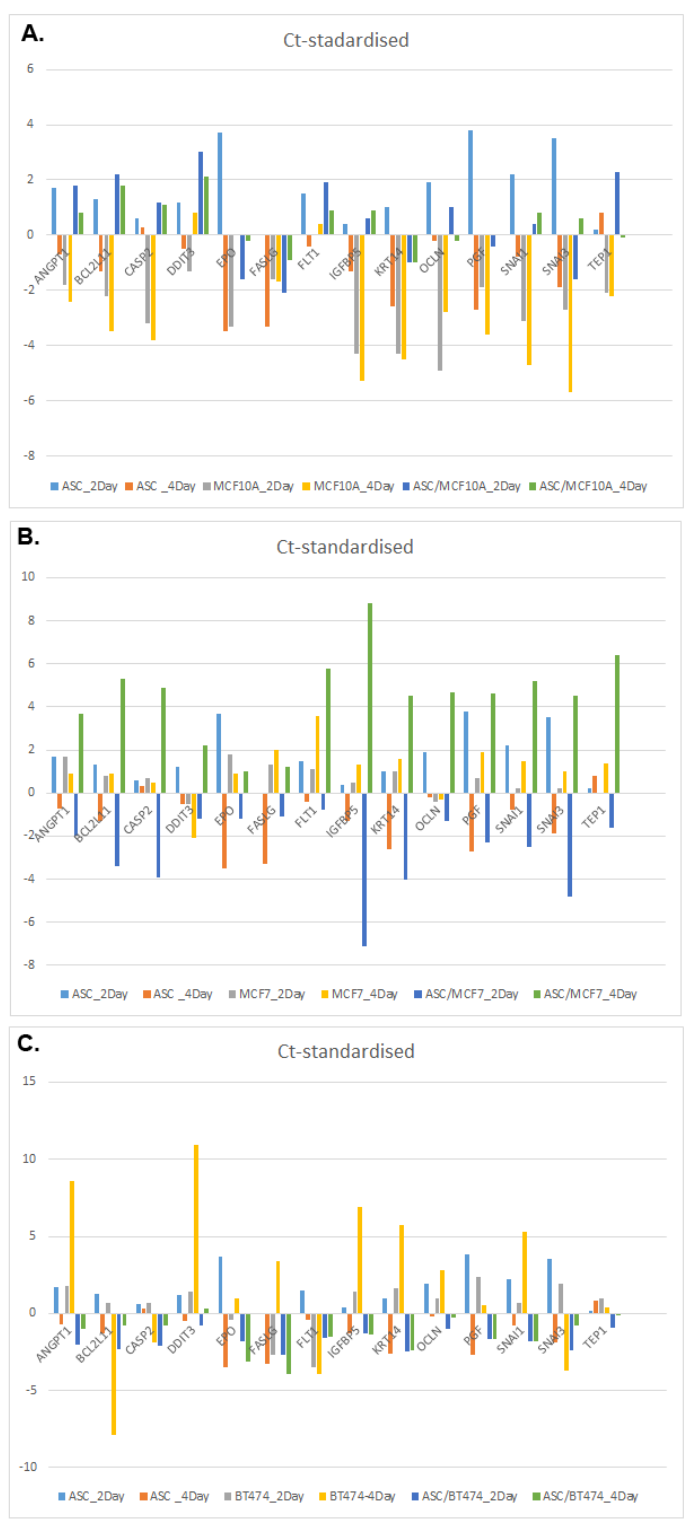
Figure 5. Expression patterns of the 14 genes with the strongest variations. For an overview of the gene abbreviations, please refer to Table 1. A positive value indicates a higher Ct value and thus down-regulated gene expression. A negative value means earlier and thus increased gene expression. ( A ) Expression patterns of ASC, MCF-10A cells and co-cultures. ( B ) Expression patterns of ASC, MCF-7 cells and co-cultures. ( C ) Expression patterns of ASC, BT-474 cells and